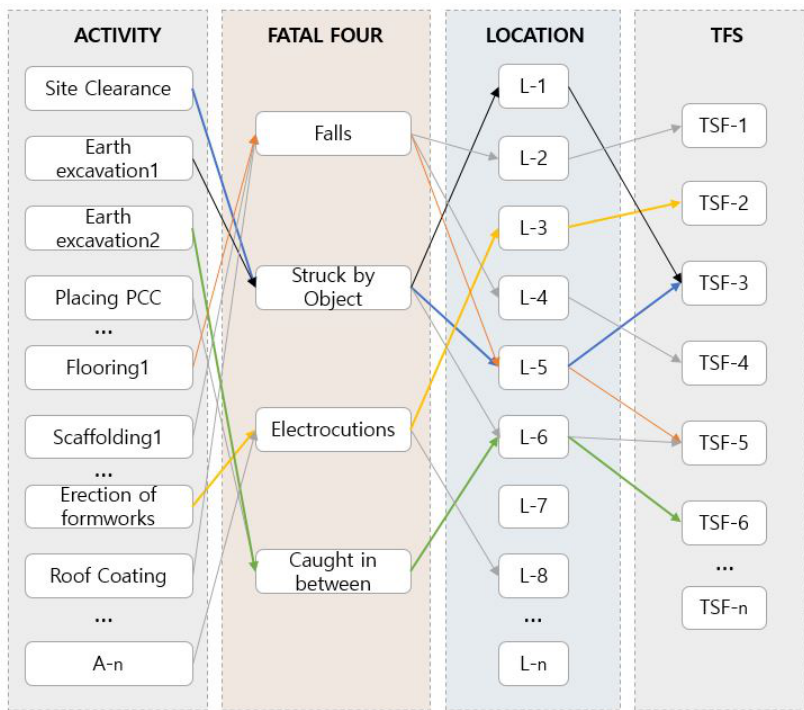
Figure 7. Logic of TSF system development.